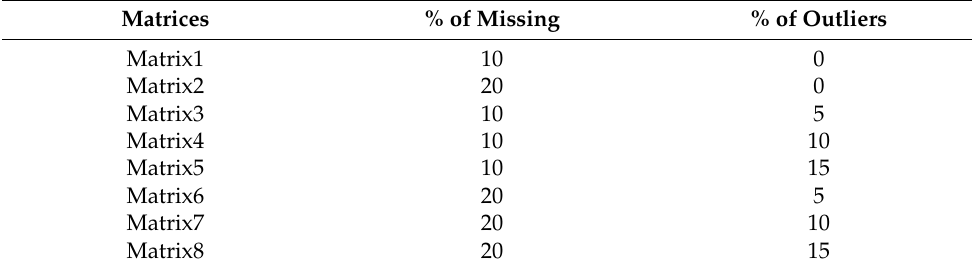
Table 1. Characteristics of the simulated